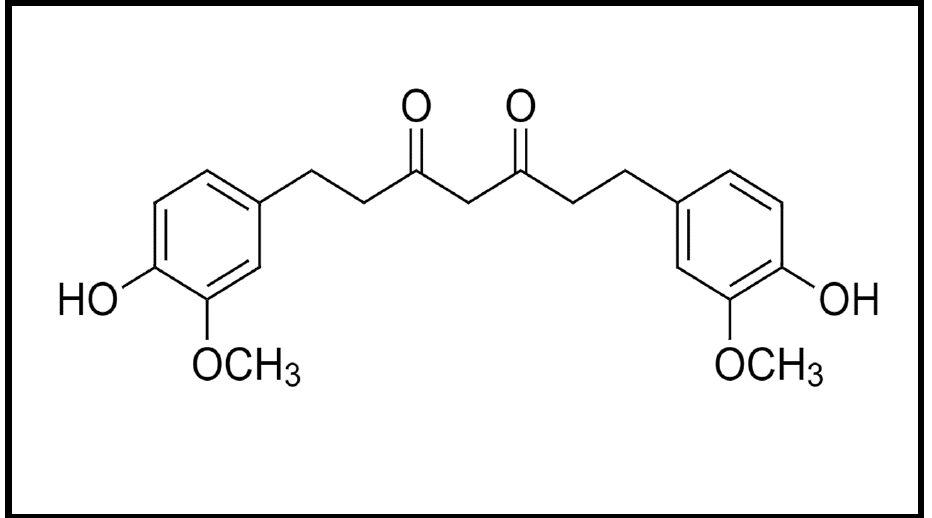
Figure 1. Chemical structure of curcumin.